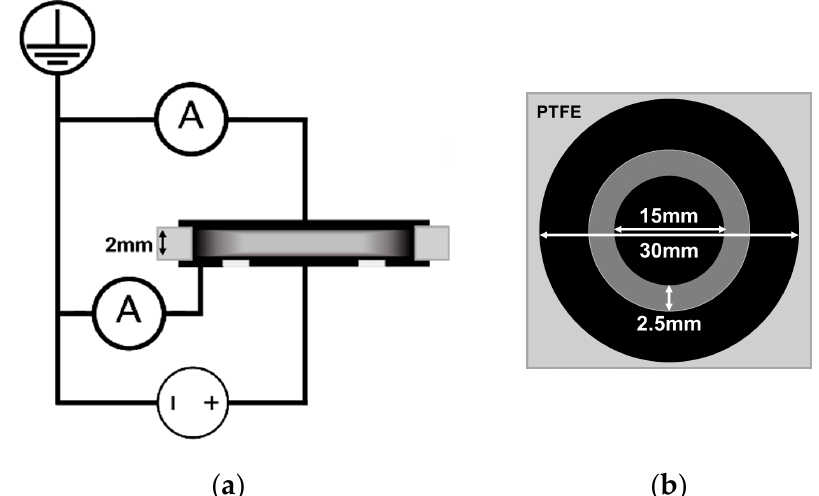
Figure 13. Experimental three-electrode scheme for measurement of the electrical resistance of a composite melt with separation of the surface and bulk components: ( a )—side view; ( b )—top view. The obtained electrical resistivity dependences on time, carried out for a wide range of content of each type of filler (CB, GnPs, SWCNTs) in the composites, showed that for any type of filler the kinetic curves for the resistivity of the near-surface layer and the volume of the composite are have noticeable differences, even at relatively high initial filler contents (Figure 14). Considering that the values of the surface component are very rough upper estimates, a high level of surface conductivity can be explained by a high concentration of an electrically conductive filler in a near-surface layer of a certain thickness, which can increase during the process of the composite being in the melt state at a fixed temperature. Unfortunately, due to some artifacts, observed for composites with low content of the fillers, no reliable kinetic curves for the resistivity can be presented at this moment. Although it should be noted that the tendencies, visible for the relatively high contents of the filler, are also present for the composites with a low filler